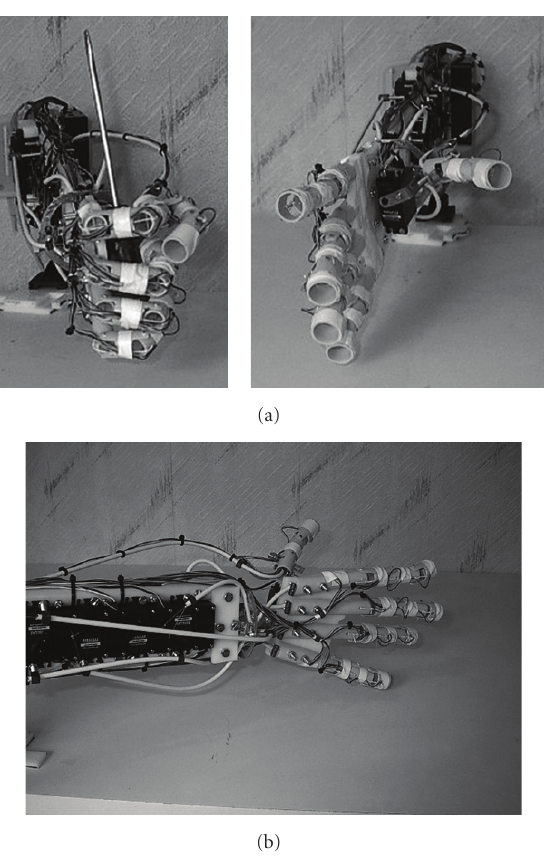
Figure 1: The LUCS Haptic Hand III while holding a screw driver, in open position seen in a front view and in a side view. Some of the actuators in the forearm can also be seen in the side view. The 12-d.o.f robot hand has five fingers, is of the same size as a human hand, and all its parts have approximately the same proportions as their counterparts in a human hand. Each finger can be separately flexed/extended in the proximal joint, whereas the medial and distal joints are flexed/extended together as real human fingers. As a human hand, the thumb has only a proximal and a distal phalang. These can also be separately flexed/extended. In addition the thumb can also be adducted/abducted in a way similar to the human thumb. The wrist is capable of flexion/extension. The actuators of the LUCS Haptic Hand III are controlled via an SSC-32 (Lynxmotion Inc.). The proprioceptive sensors are scanned with a MAX396CPI multiplexor chip and digitalized using an NiDaq 6008 (National Instruments). The NiDaq 6008 converts multiple analog input signals to digital signals, which are conveyed to the computer via a USB-port. The robot hand is equipped with two multiplexor chips, which means it is prepared for 21 additional